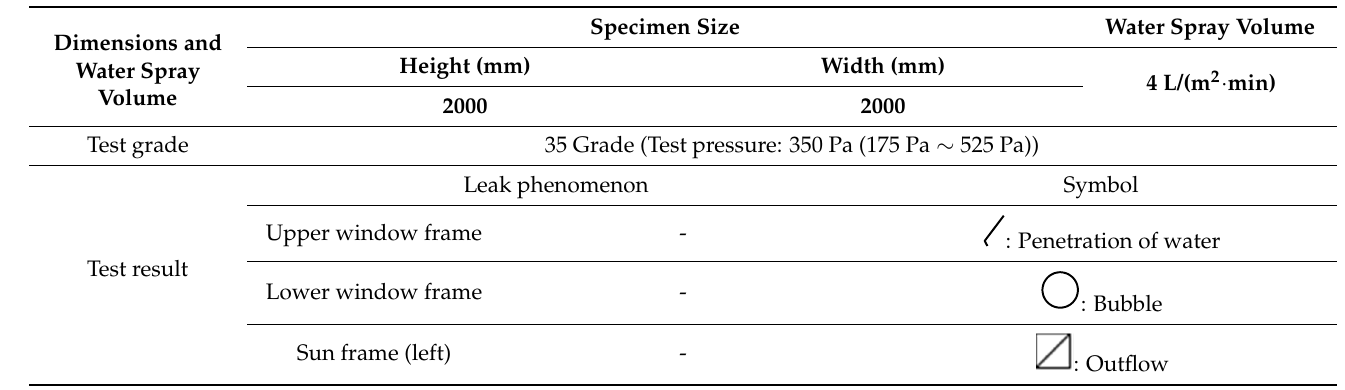
: Spray : Spray out of the frame : Overflow out of the frame 35 grade suitable Leak location ※ No leakage phenomenon. Laboratory envi-